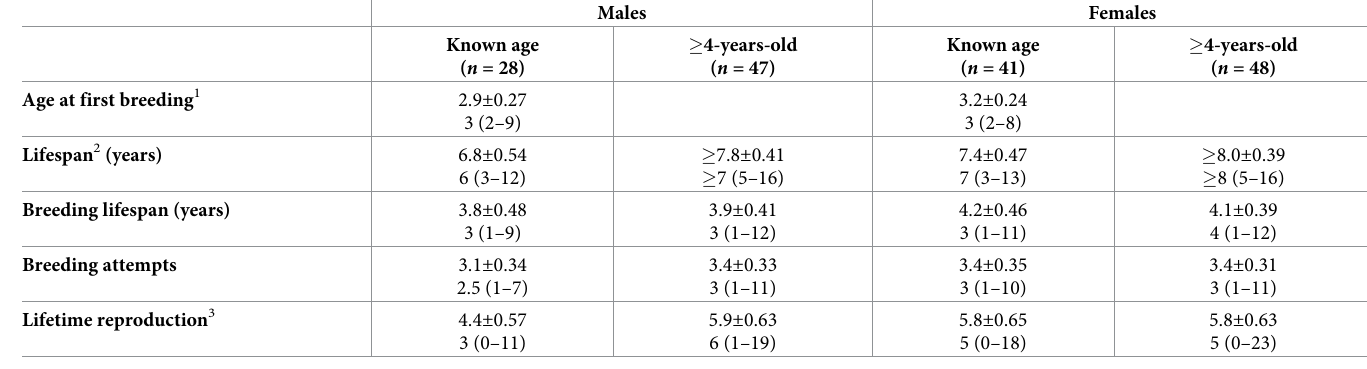
slightly longer for the � 4-year-old group (8.0 years) than for the known-age group (7.4 years). Interestingly, while mean LR in the 2 groups were the same for females (5.8 fledglings), the Table 2. Life history characteristics of breeding goshawks. Mean ± SE and median (range) of age at first breeding, lifespan, breeding lifespan (first to last breeding year), number of breeding attempts, and lifetime production (LR) of fledglings of 164 (69 known-age plus 95 � 4-years-old) male and female northern goshawks first breeding in the 1992–2000 cohorts in Arizona,